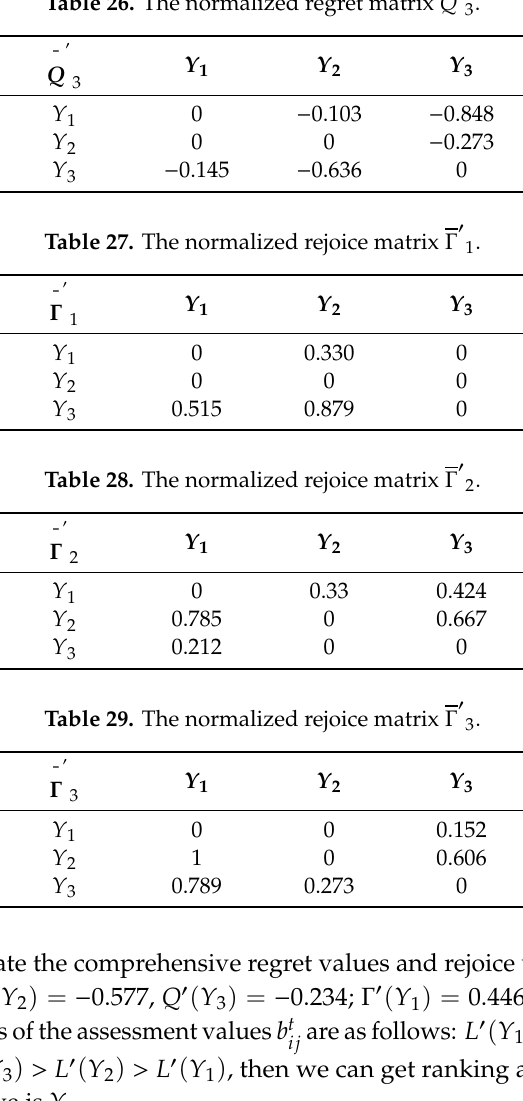
Table 26. The normalized regret matrix Q